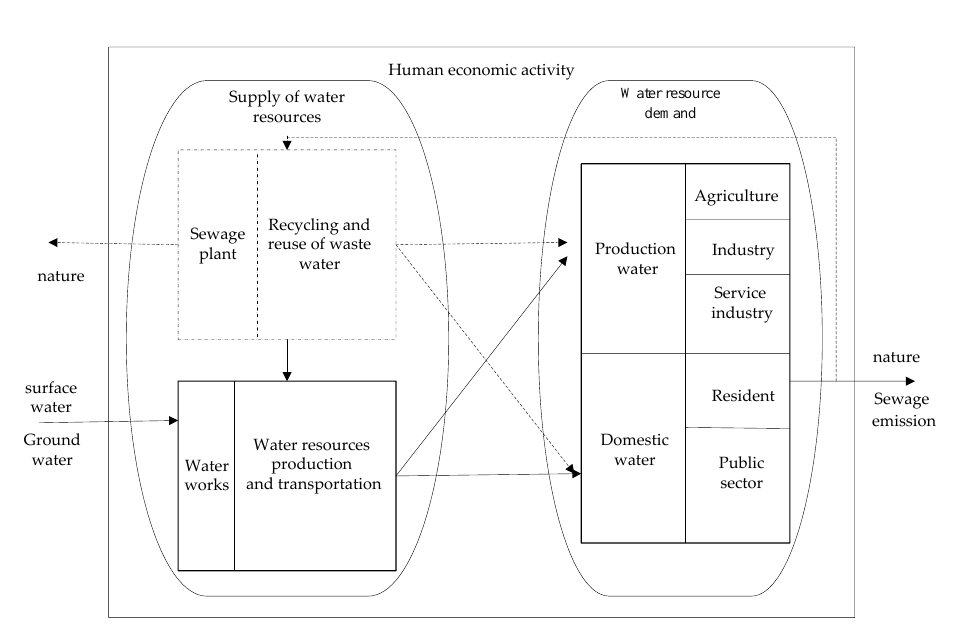
Figure 1. Circular flows of water resources.